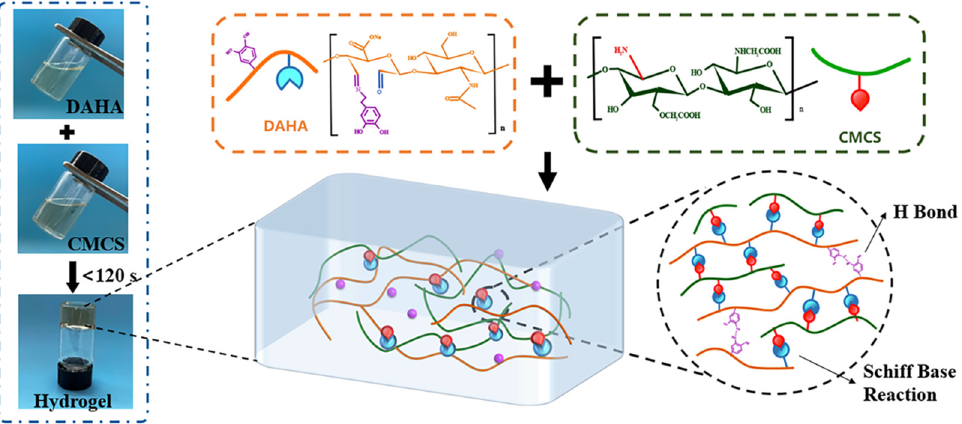
Figure 1. Schematic diagram of crosslinking within DACS hydrogels by mixing DAHA and CMCS solutions.